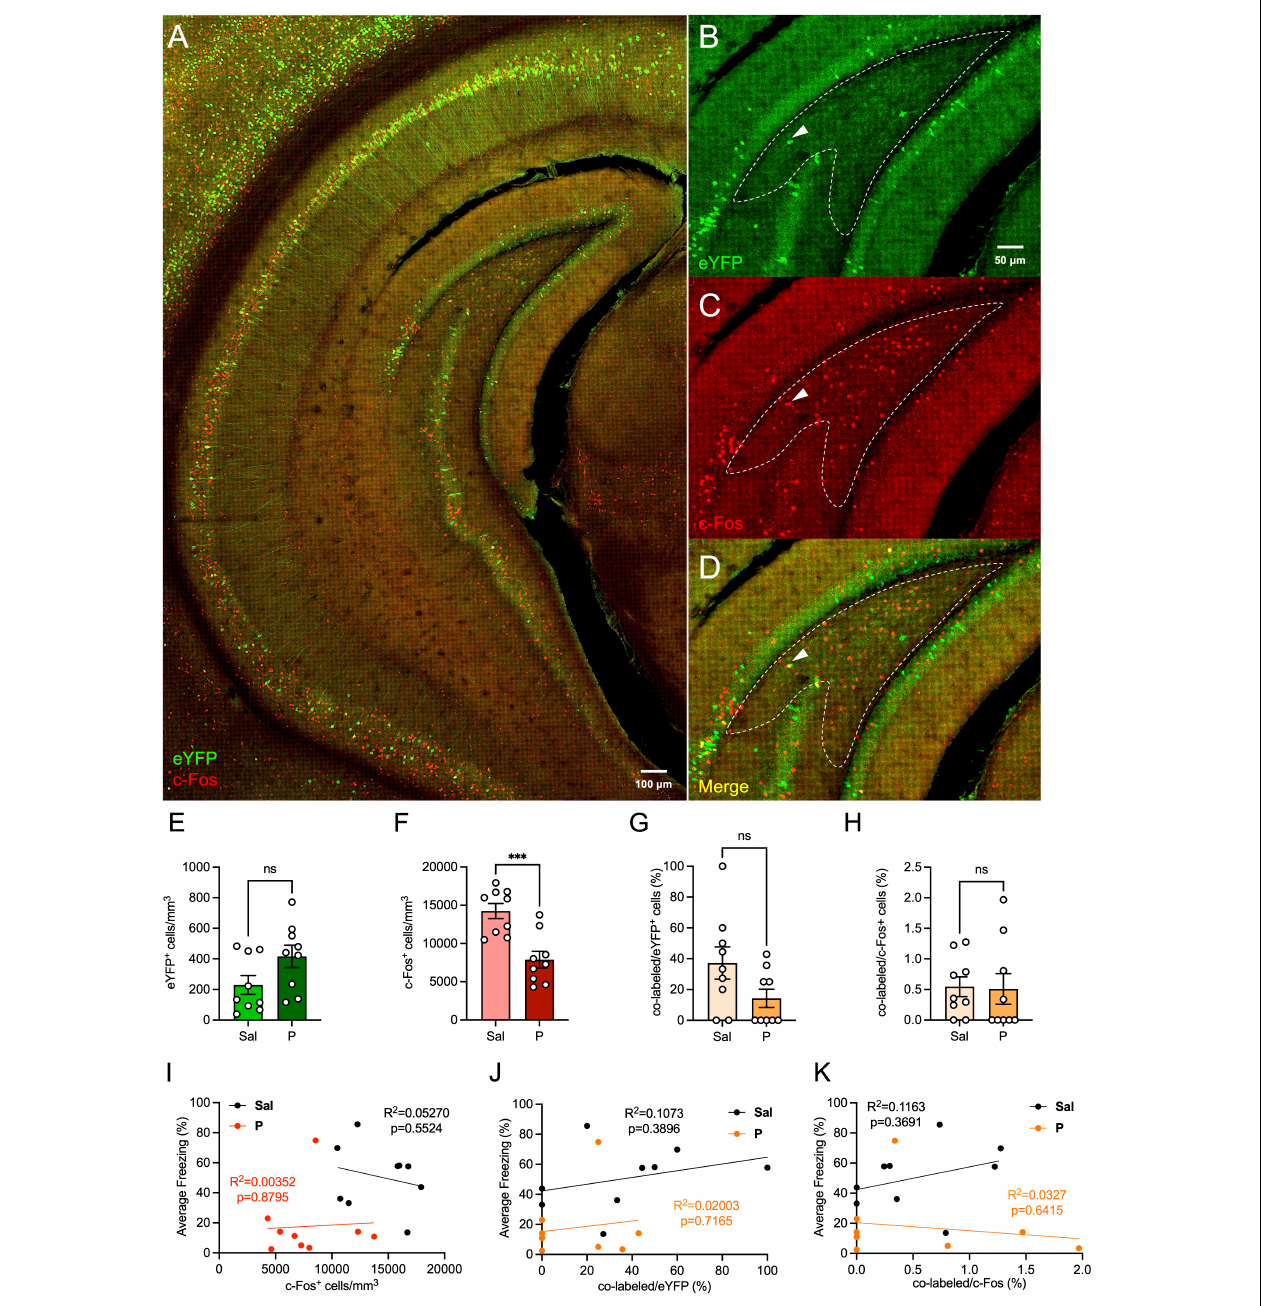
FIGURE 2 | Propranolol administration decreases hilar neural activity in the ventral hippocampus. (A) Representative section showing eYFP (green) and c-Fos (red) expression throughout the brain in the ArcCreER T2 × eYFP mice. (B) eYFP + , (C) c-Fos + , and (D) co-labeled cells in the ventral hilus. Representative hilar sections are outlined in white. (E) eYFP + , (F) c-Fos + , (G) co-labeled/eYFP (%), and (H) co-labeled/c-Fos + (%) hilar cell counts in the ventral hilus. Correlation plots of average freezing versus (I) c-Fos + cells, (J) co-labeled/eYFP + (%), and (K) co-labeled/c-Fos + (%). Error bars indicate ± SEM. ∗ p < 0.05, ∗∗ p < 0.01, ∗∗∗ p < 0.0001. eYFP, enhanced yellow fluorescent protein; Sal, saline; P, propranolol; ns, non